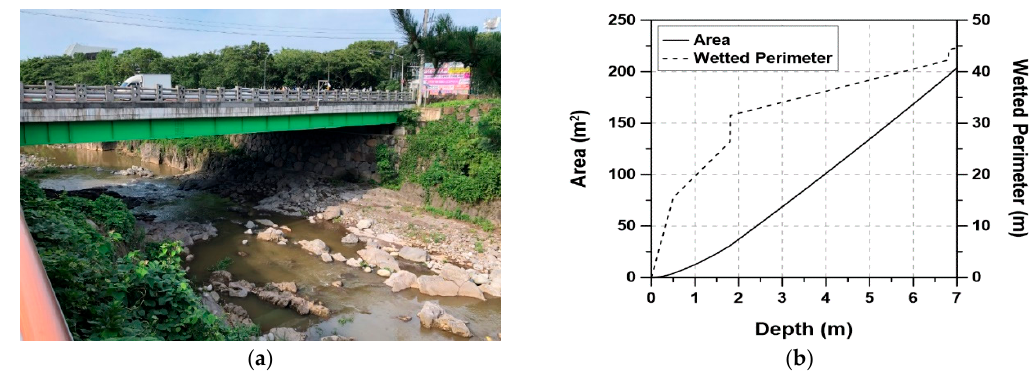
Figure 3. Picture of the Second Dongsan Bridge ( a ) and the relation curves of depth ‐ area and depth ‐ wetted perimeter ( b ).